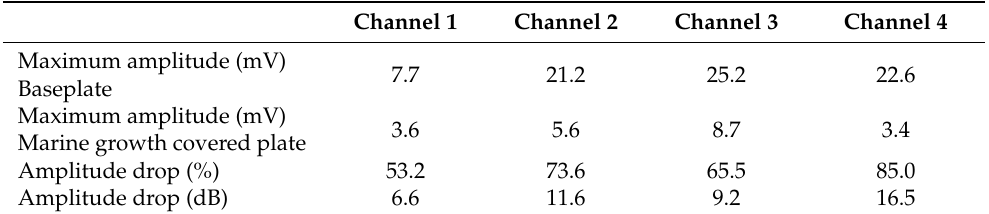
Table 1. Maximum amplitudes of acquired signals with an amplitude drop between the baseplate and marine growth covered plate experiment.